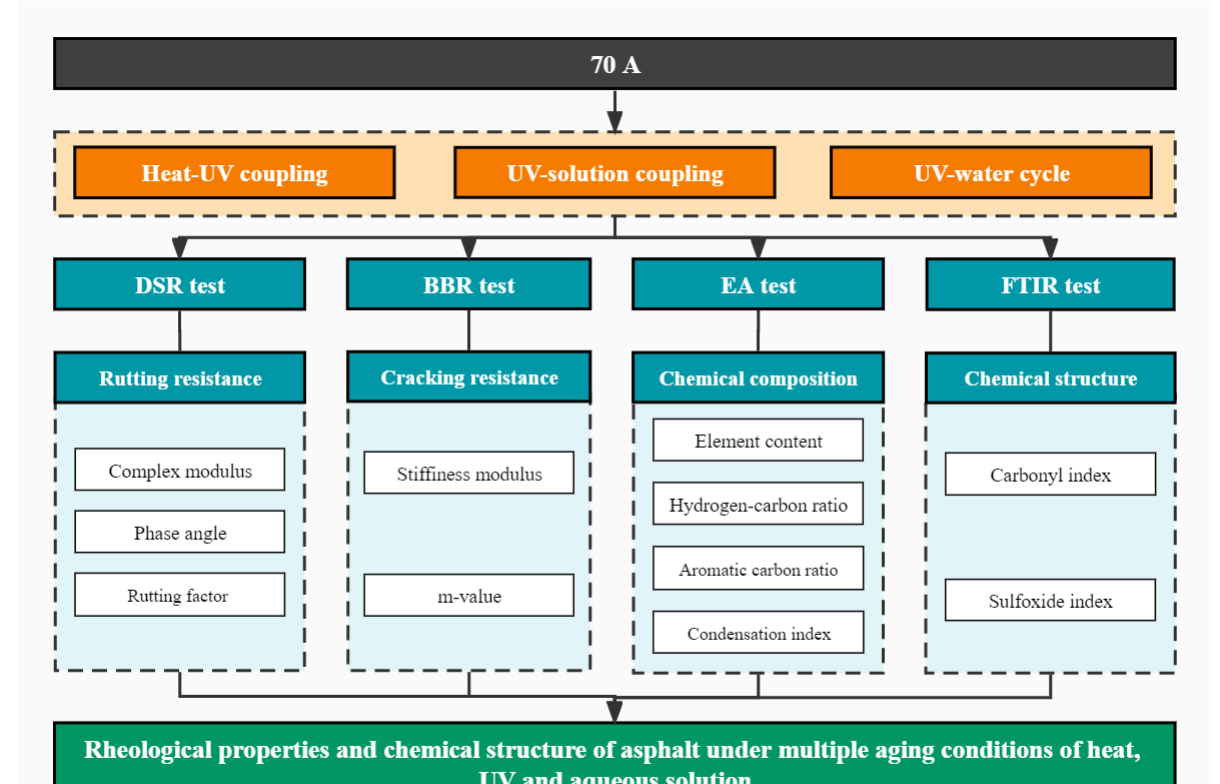
Figure 1. Research program.